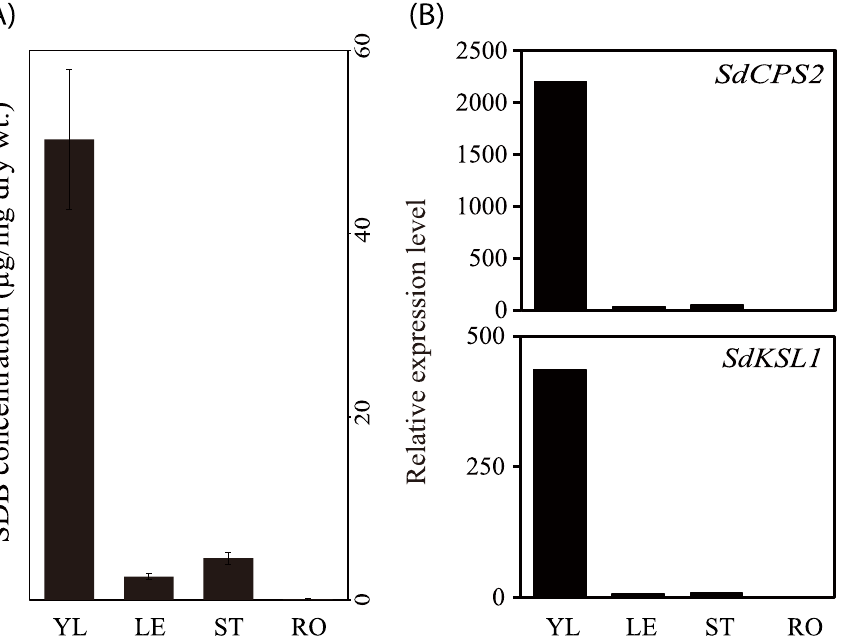
Figure 4. Quantification of SDB production and qRT-PCR analysis of the expression level of SdCPS2 and SdKSL1 in S. dulcis tissues. ( A ) Quantification of scopadulcic acid B ( 1 ) by HPLC in S. dulcis tissues. YL: young leaf, LE: leaf, ST: stem, and RO: root. ( B ) The 18S rRNA gene was used for normalization. The transcript level of each gene in the root was set to